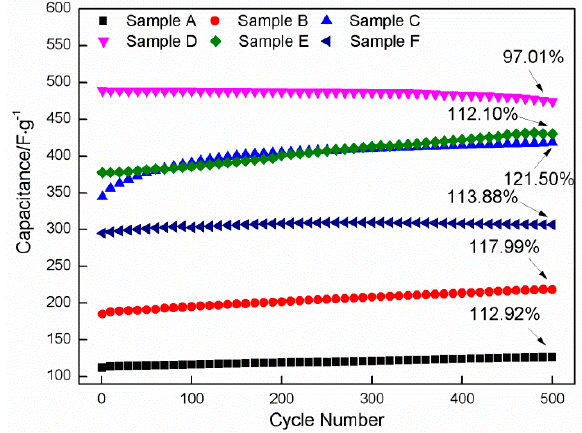
Figure 14. Cycling tests for Samples A–F at a scanning rate of 50 mV·s − 1 up to 500 cycles.